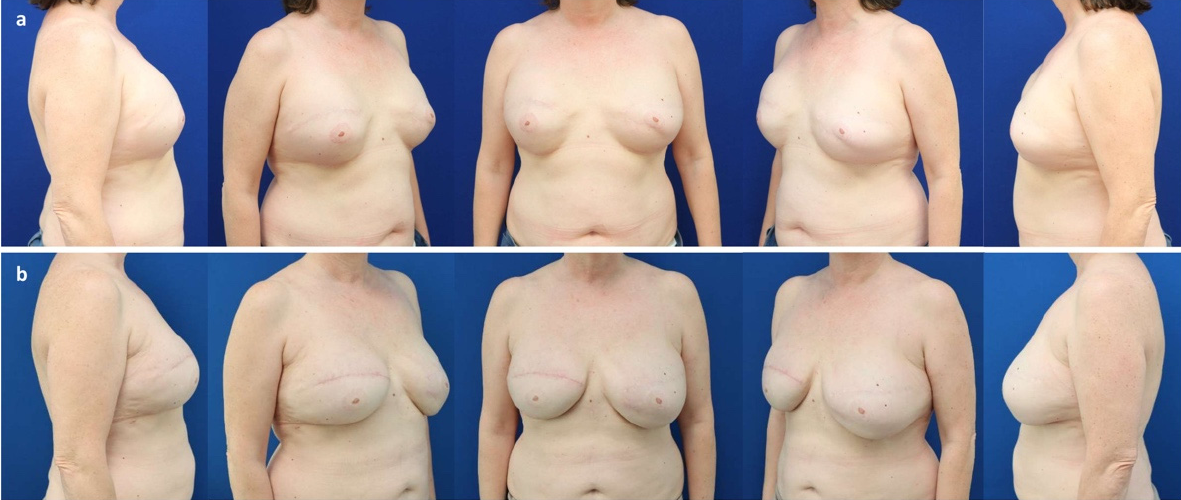
Figure 8. ( a ) A 54-year-old patient with state after a bilateral mastectomy for multifocal invasive ductal carcinoma (pT3 pN2 (10/10) M0) of the right breast and prophylactic mastectomy of the left breast, as well as immediate subpectoral expander-to-implant-based reconstruction elsewhere, followed by adjuvant immuno-chemotherapy. Note the bilateral capsular contracture (Baker classification grade IV). ( b ) Two years after a pocket change from subpectoral to prepectoral, exchange of the implant (Motiva Ergonomix ® ERSD 575 cc), and autologous fat grafting to the mastectomy flaps (220 cc/side) without mesh-support. Note bottoming out of the left.